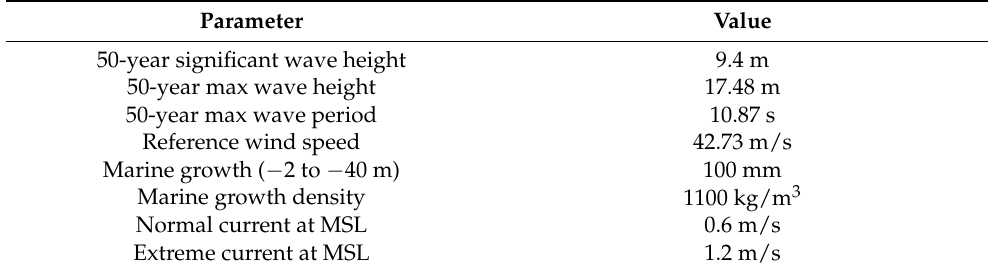
Table 1. Site-specific